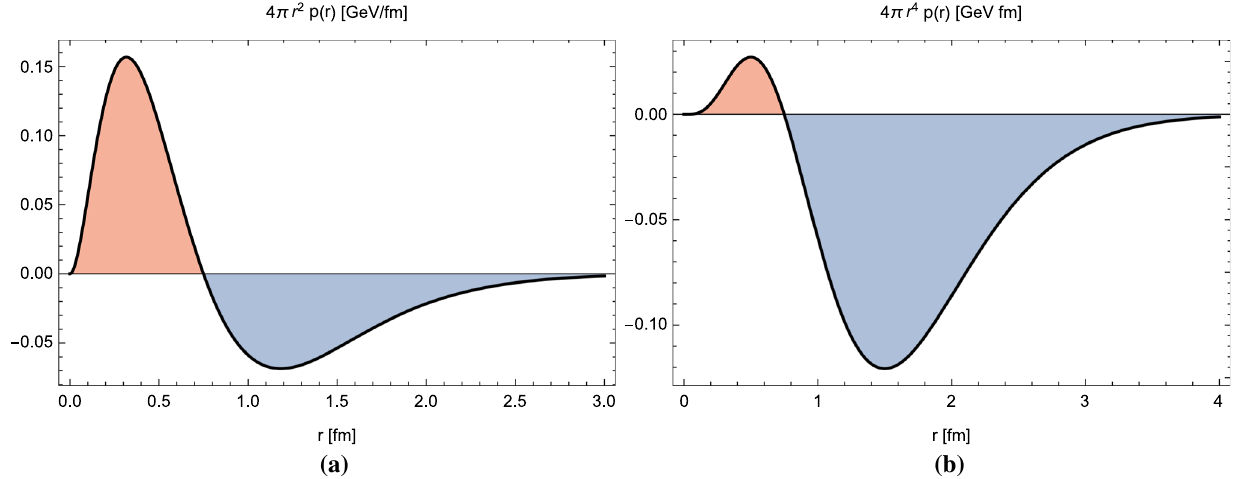
Fig. 19 Illustration of the hydrostatic equilibrium in the Breit frame. a Integrand of the von Laue condition (120) and b the same integrand multiplied by r